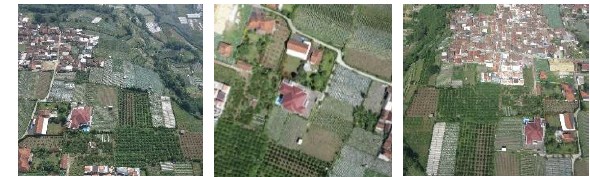
Figure 5 Oblique and vertical UAV aerial photo